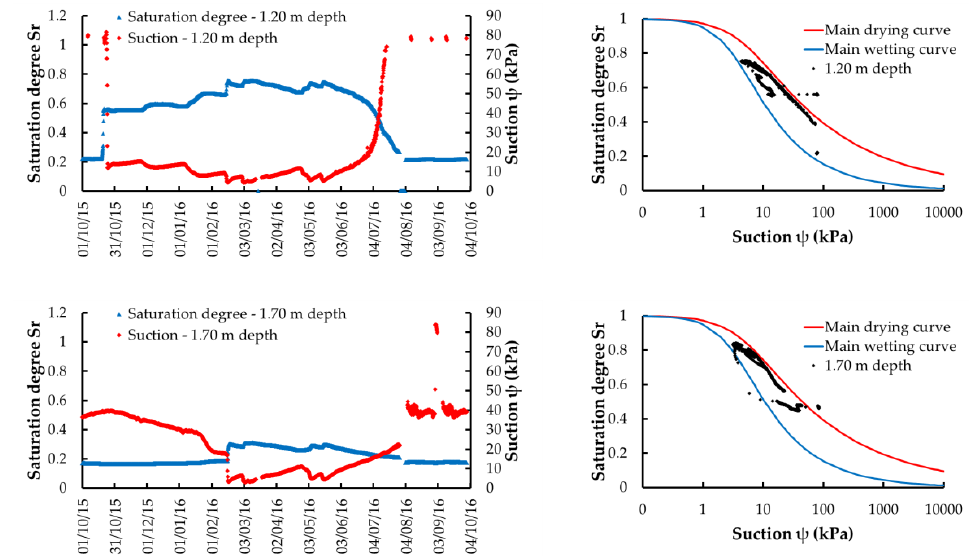
Figure 6. (Left) Suction and degree of saturation trend at the different depths. (Right) Relation between suction and degree of saturation recorded on site and the main water retention curves.